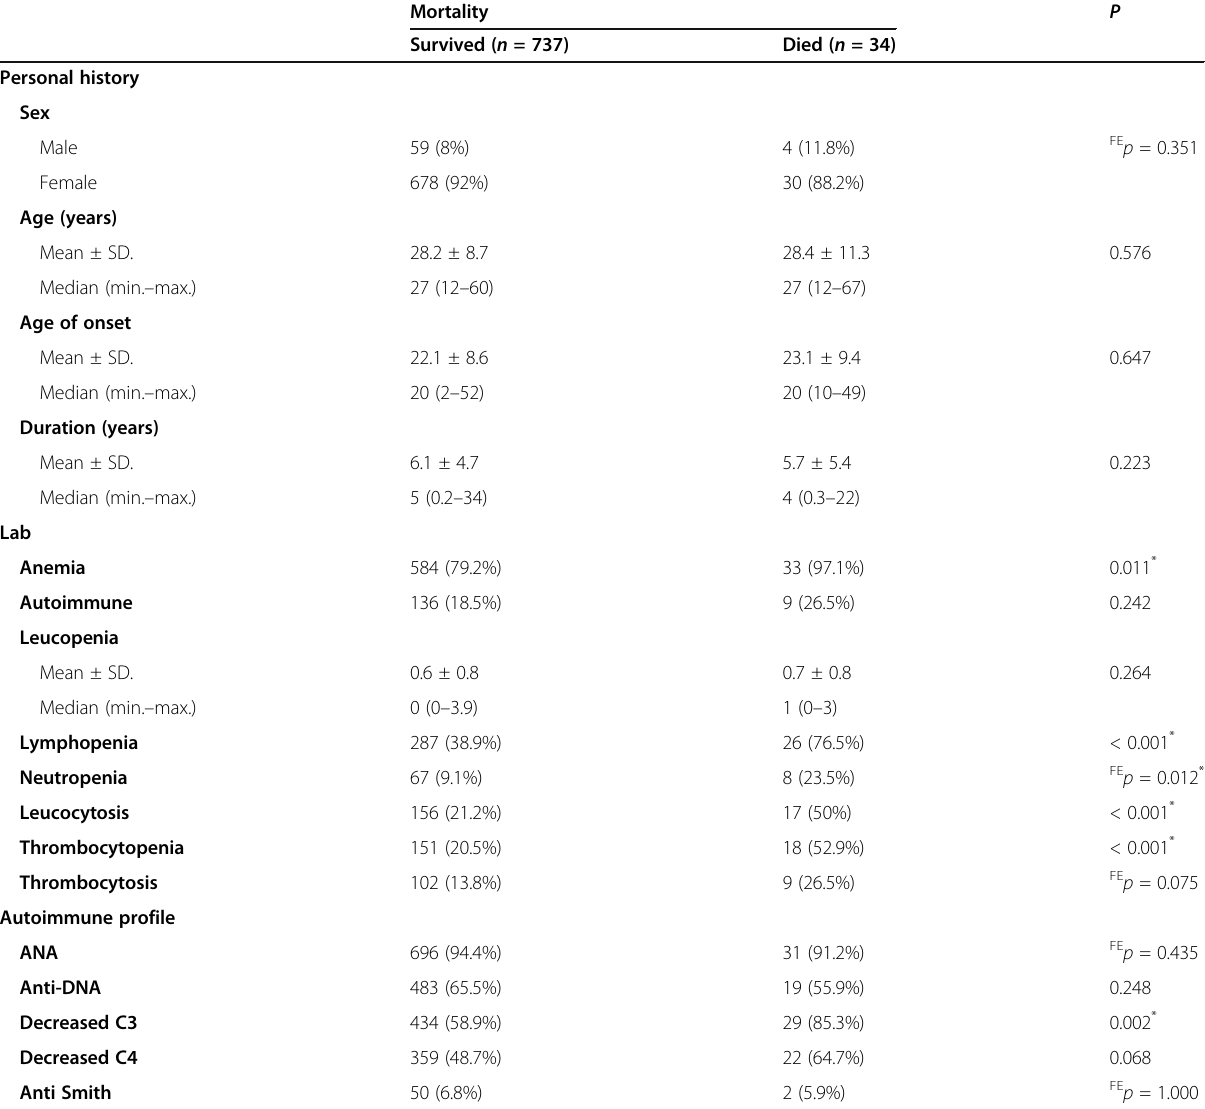
Table 2 Relation between mortality and demographic, laboratory and immunological parameters Mortality P Survived ( n =